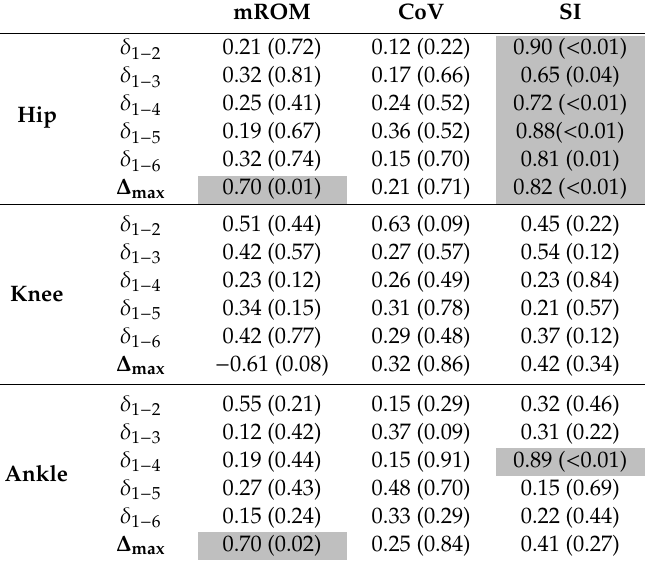
Table 8. Correlation coe ffi cient (adjusted p -value) related to the correlation between expanded disability status scale (EDSS) and each of the computed parameter for the most and variable side of patients. Gray cells indicate strong and significant